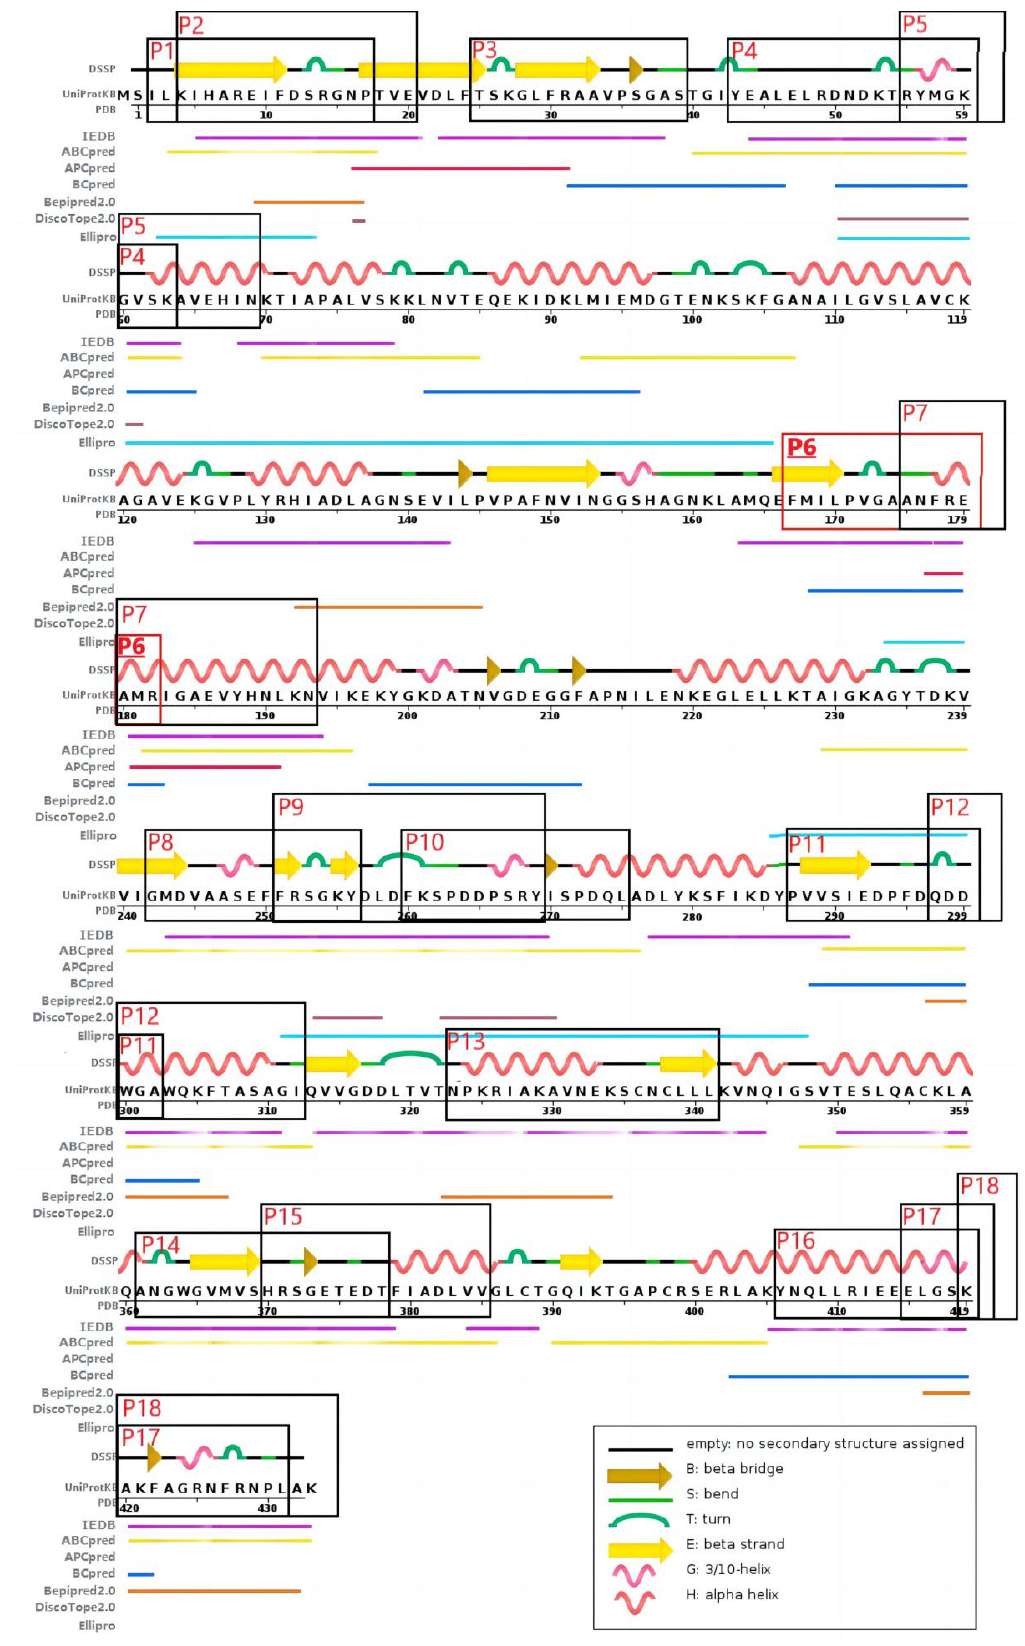
Figure 4. The 18 selected antigenic epitopes of human ENO1 protein predicted by databases.